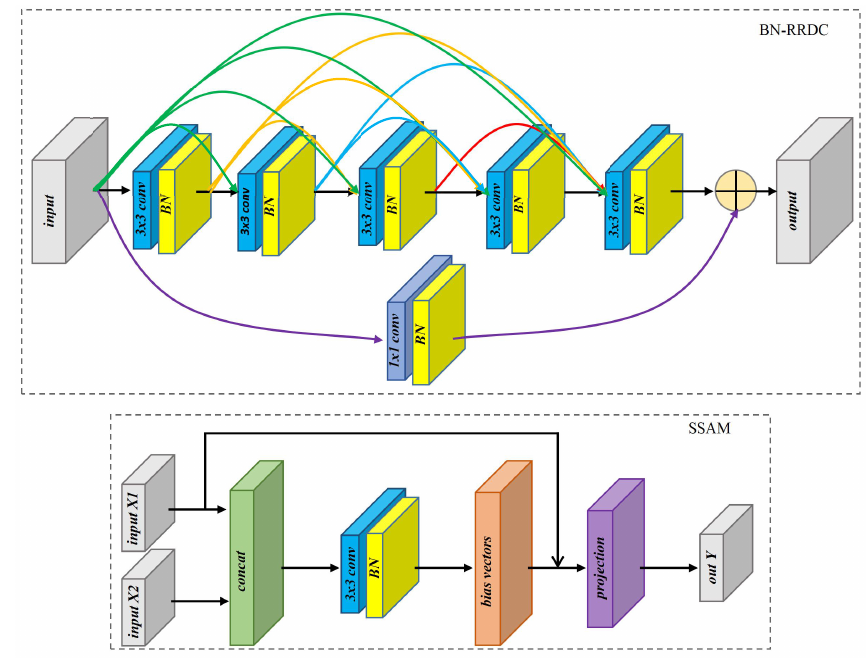
Figure 5. The detailed structure of BN-RRDC block and